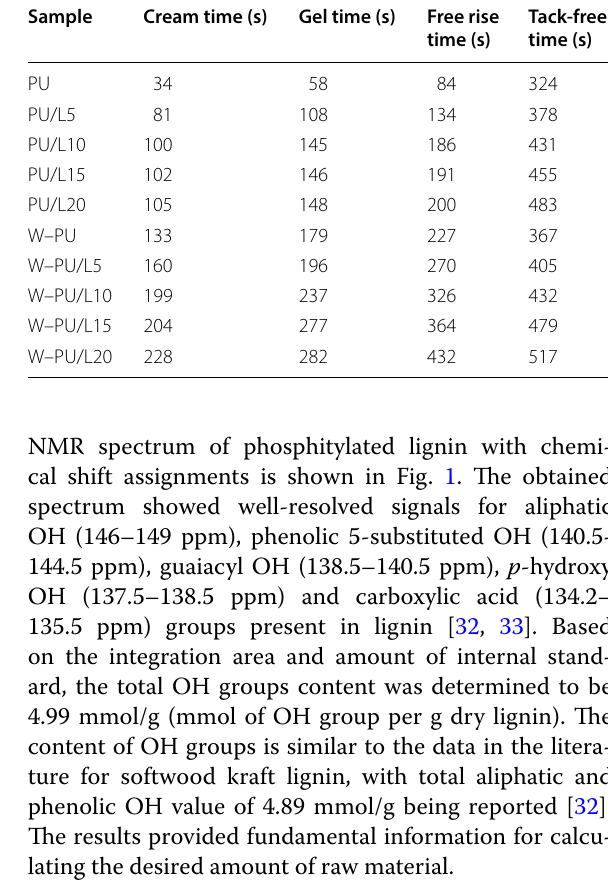
Table 2 Foaming characteristic times of the PU and